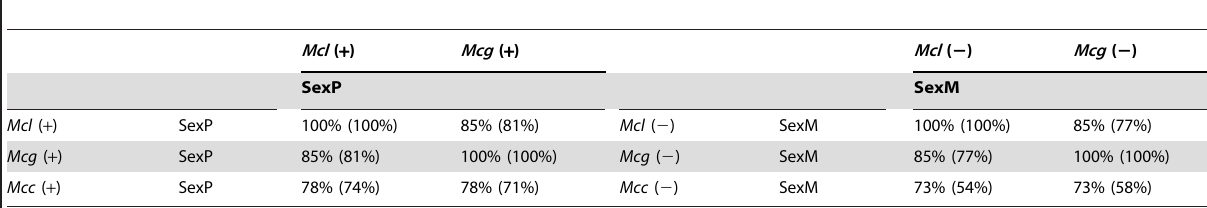
Table 5. Comparison of SexP (left) and SexM (right) in the three